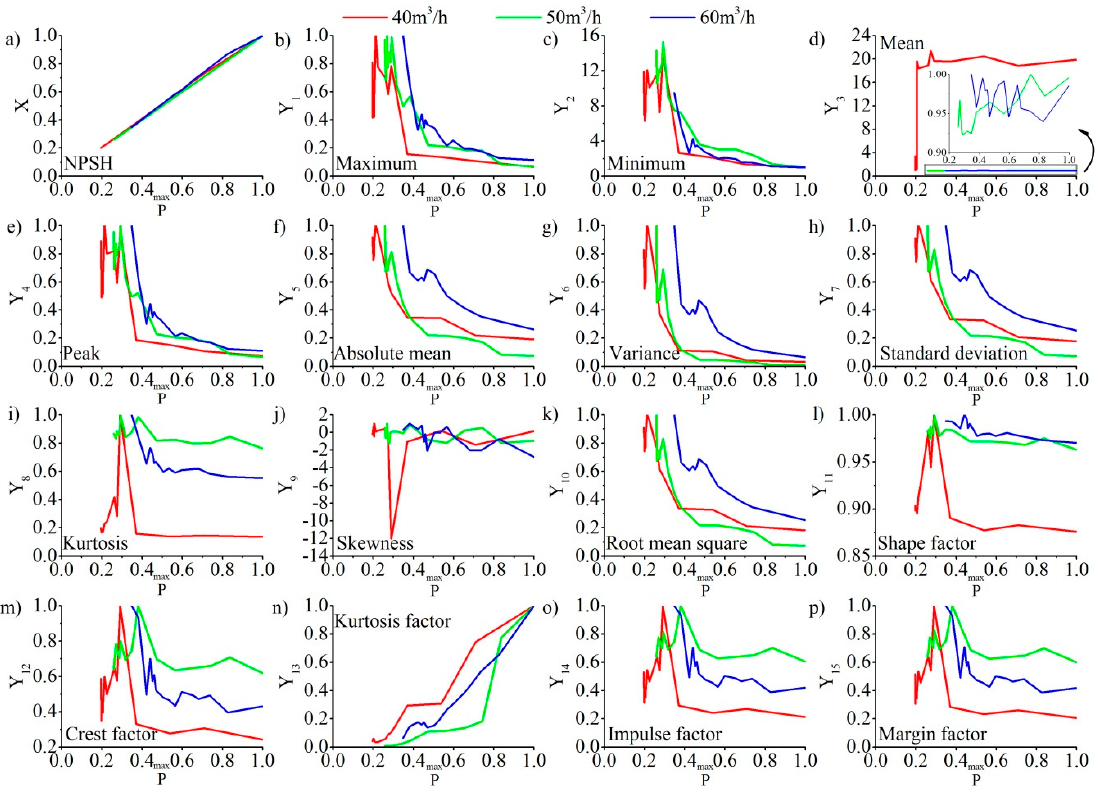
Figure 4. Normalization value: ( a ) NPSH, ( b ) Maximum, ( c ) Minimum, ( d ) Mean, ( e ) Peak, ( f ) Absolute mean, ( g ) Variance, ( h ) Standard deviation, ( i ) Kurtosis, ( j ) Skewness, ( k ) Root mean square, ( l ) Shape factor, ( m ) Crest factor, ( n ) Kurtosis factor, ( o ) Impulse factor, ( p ) Margin factor